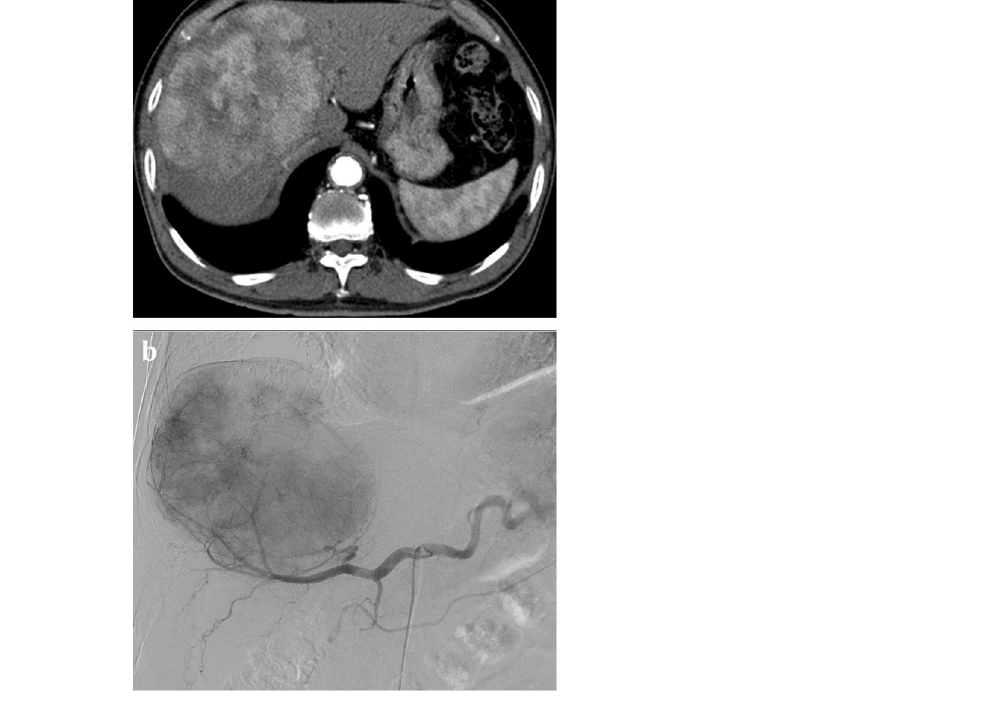
Figure 2. A 77 year old man with a hepatocellular carcinoma (size equal to 15 cm). ( a , b ) No dysmorphic intratumoral vessels were found on preprocedural liver computed tomography (CT) scans ( a ), and planning hepatic arteriography ( b ). In addition, there was no hepatic vein invasion or early hepatic vein enhancement on CT. The lung-shunt fraction was